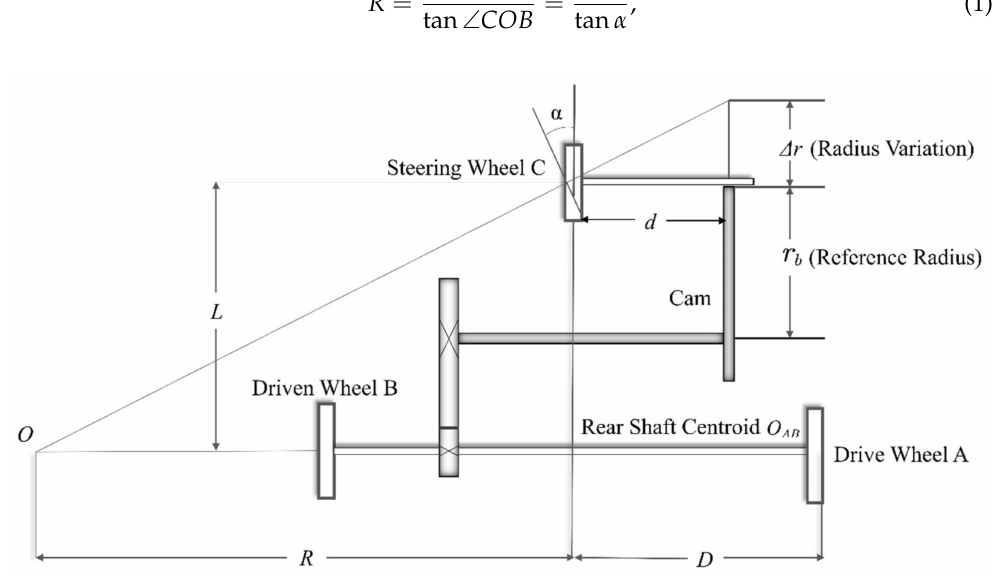
Figure 2. Steering